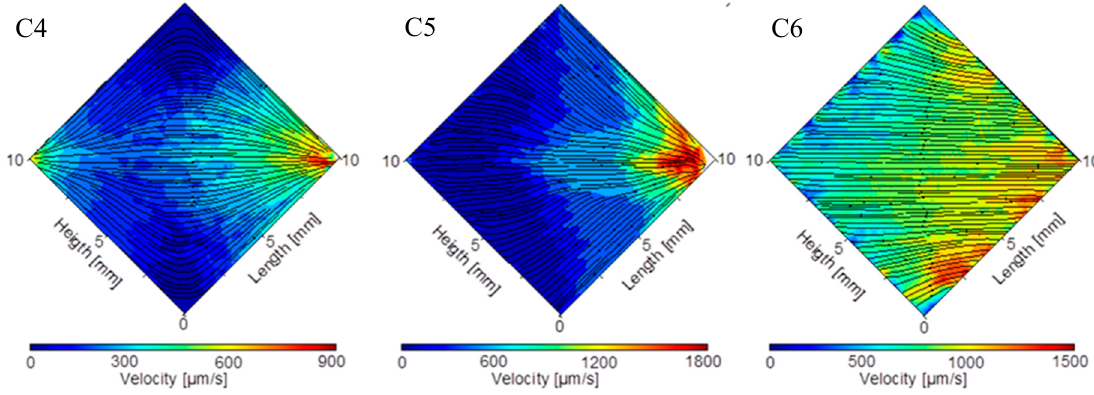
Figure 11. Flow velocity field with streamlines in the chamber measured using micro-particle image velocimetry for the microfluidic interface structure (left) C4, (center) C5, and (right) C6.